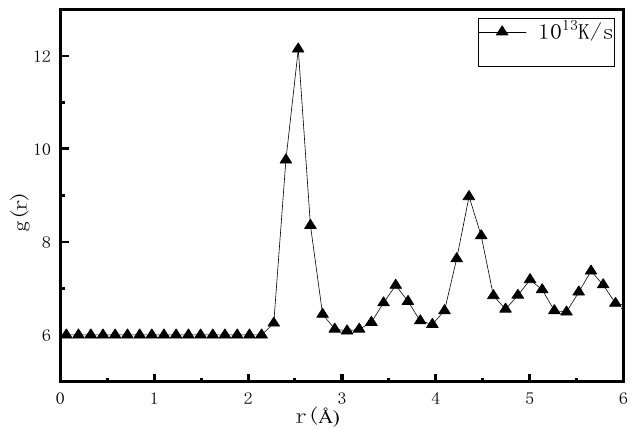
Figure 3. GBs HEAs model after solidification.